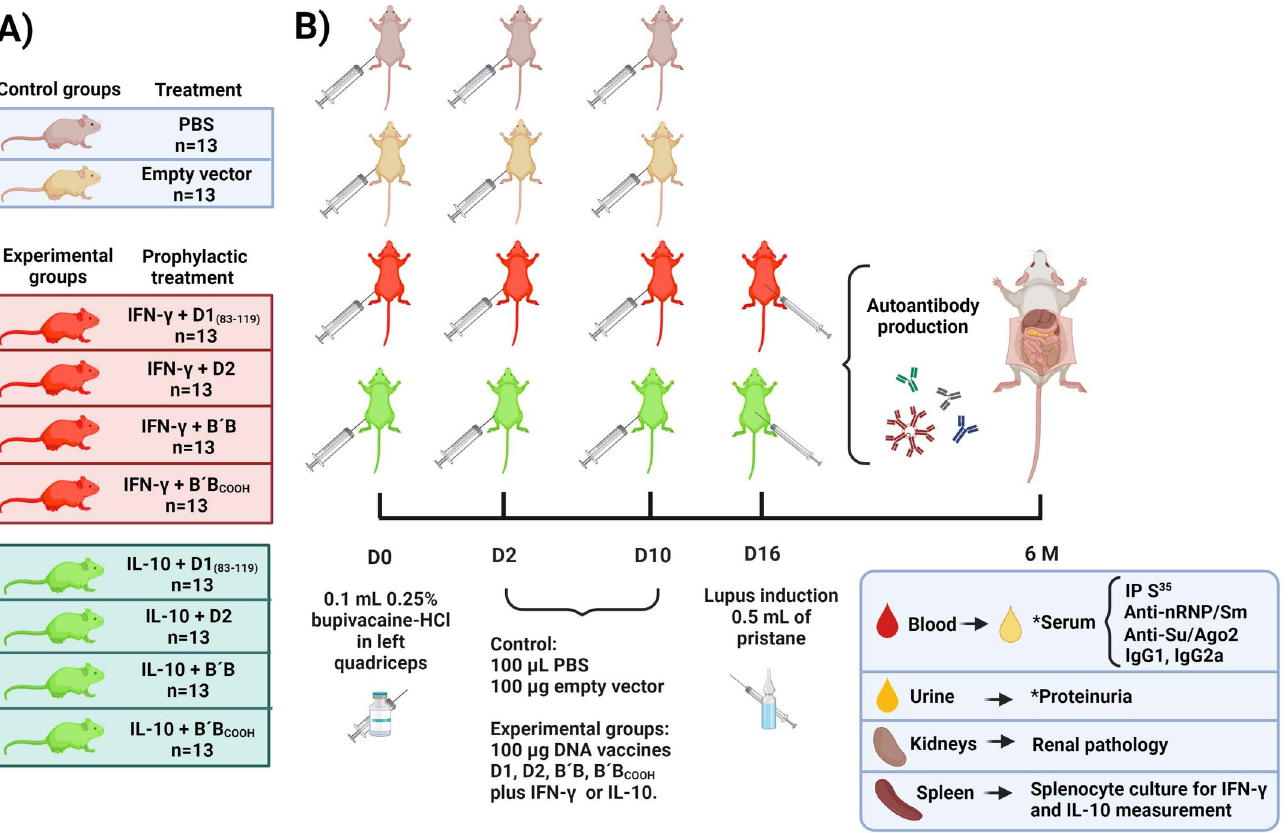
Fig 1. Schematic representation of the study design of prophylactic DNA vaccination in a murine lupus model. Panel A) Female BALB/c mice were included as control group and experimental group. Panel B) Experimental procedures timepoint for control group and prophylactic DNA vaccination group. Abbreviatures: D = day, M = month, IP = immunoprecipitation, HCl = hydrochloric acid, S = sulfur, PBS = Phosphate Buffer Solution. � In these determinations, some samples run out. Created with BioRender.com.